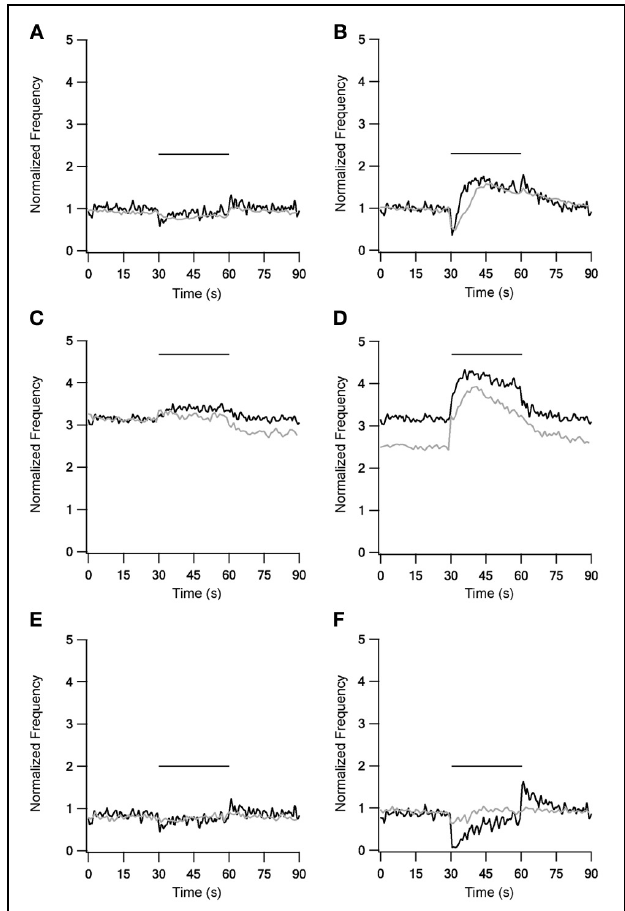
FIGURE 4 | Model and experimental results during LFS and HFS after adding mGluRs1 to STN-GP synapses. Left column, results of LFS under control conditions (A) , during blockade of inhibition (C) and blockade of excitation (E) . Right column, HFS results under control conditions (B) , during blockade of inhibition (D) and blockade of excitation (F) . Black traces, model results; gray traces, normalized population average recorded from GP neurons in vitro (Bugaysen et al., 2011). In these experiments inhibition was blocked with 50 μ M bicuculline and excitation with 15 μ M CNQX and 50 μ M APV. Plotted as in Figure 1 Horizontal bars indicate the stimulation period.